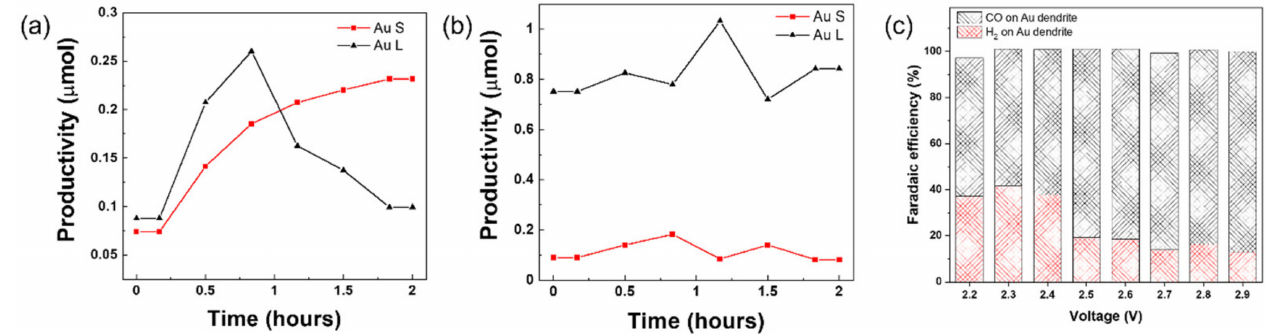
Figure 2. Galvanostatic test of CO 2 reduction and water oxidation. Productivity of ( a ) CO and ( b ) O 2 using Au S (red) and Au L (black) on the cathode. ( c ) Selectivity of CO and H 2 on Au S electrode in the range from 2.2 V to 2.9